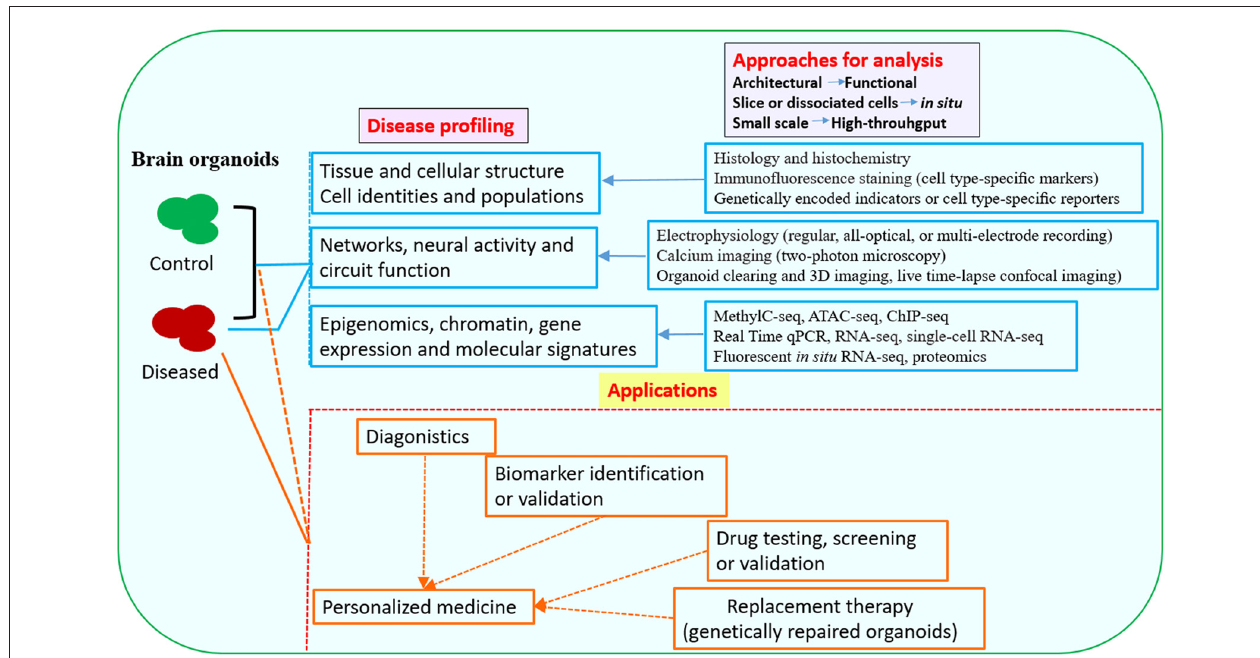
FIGURE 2 | Downstream analysis and applications of human brain organoid models of neurological diseases. Conventional methods used in neurobiology might not be able to exploit the neuronal activity and network connectivity within the 3D architecture of brain organoids. The combination of advanced multi-level and high-throughput detection techniques which allow analysis of the whole or intact brain organoids, will greatly benefit phenotypic profiling of human brain organoid models and may help to further uncover mechanisms for disease pathogenesis (Mariani et al., 2015; Luo et al., 2016; Qian et al., 2016; Quadrato et al., 2016; Bershteyn et al., 2017; Hartley and Brennand, 2017; Renner et al., 2017; Xiang et al., 2017; Pas , ca, 2018). The brain organoid models could be potentially used in drug testing or screening, identification of new biomarkers or development of innovative diagnostics and therapeutics. Patient-derived brain organoids, together with drug testing, diagnostic or therapeutic approaches, might eventually lead to personalized medicine for the individuals (Kelava and Lancaster, 2016a; Qian et al., 2016; Quadrato et al., 2016; Di Lullo and Kriegstein, 2017; Quadrato and Arlotta, 2017). Abbreviations: ATAC-seq, assay for transposase-accessible chromatin with high-throughput sequencing; ChIP-seq, chromatin immunoprecipitation and sequencing; MethylC-seq, MethylC-sequencing; qPCR, quantitative PCR; RNA-seq,